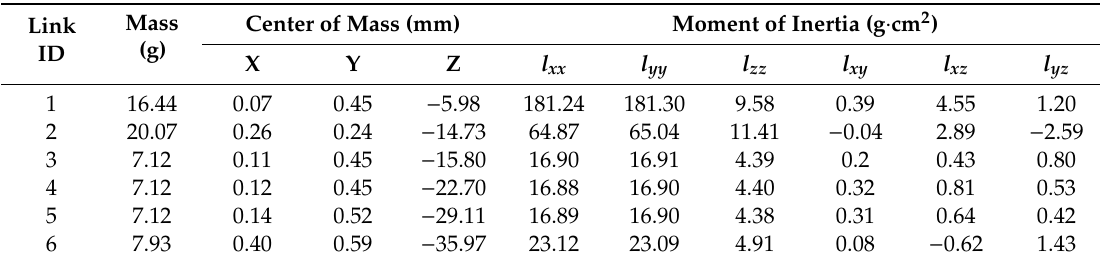
Table 1. Dynamic parameters of the snake-like